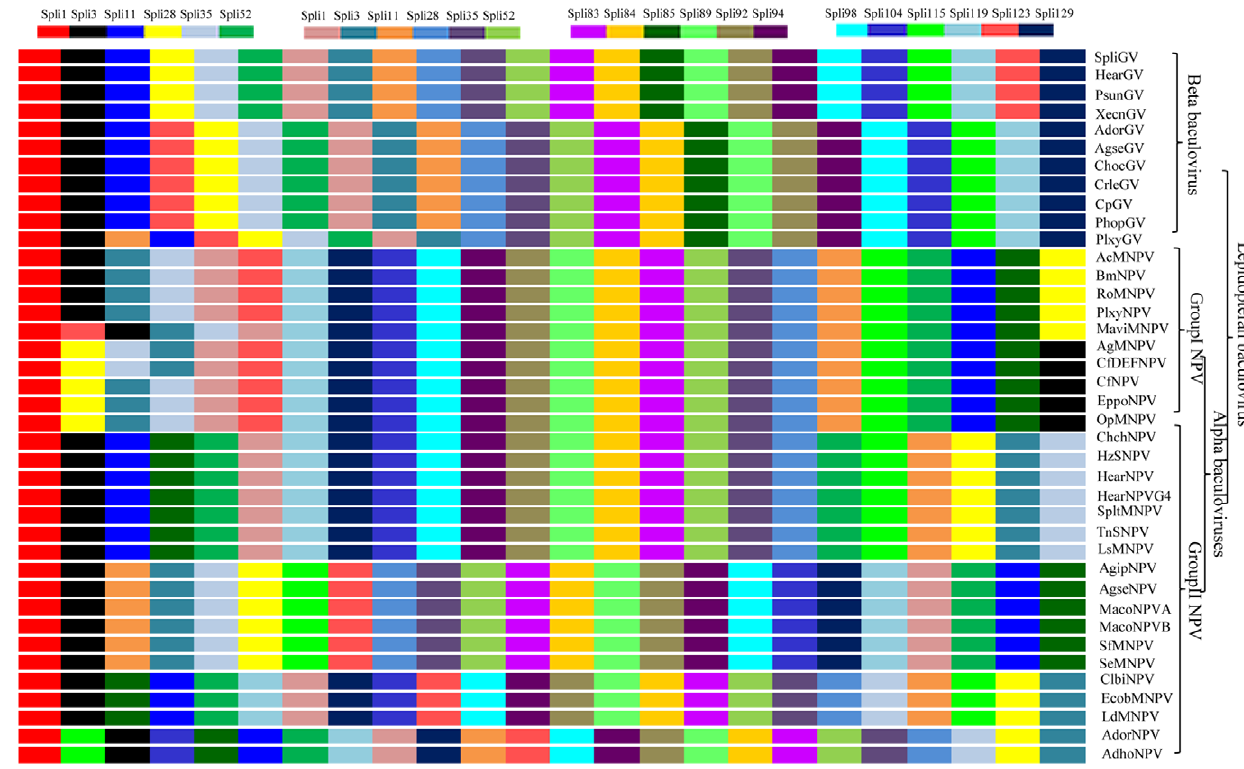
Figure 5. Gene order diagram of 24 genes from 45 complete baculovirus genomes.